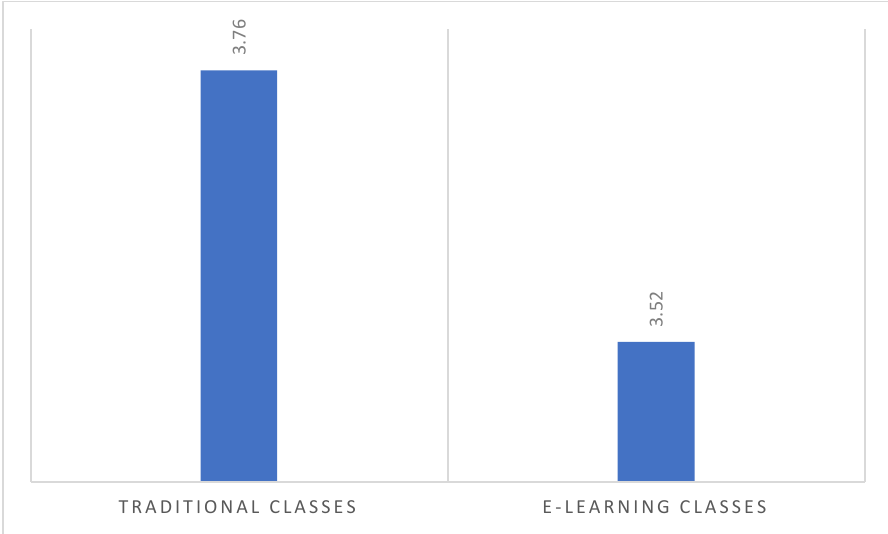
Figure 6. The ease of content acquisition in the case of traditional and e-learning classes.